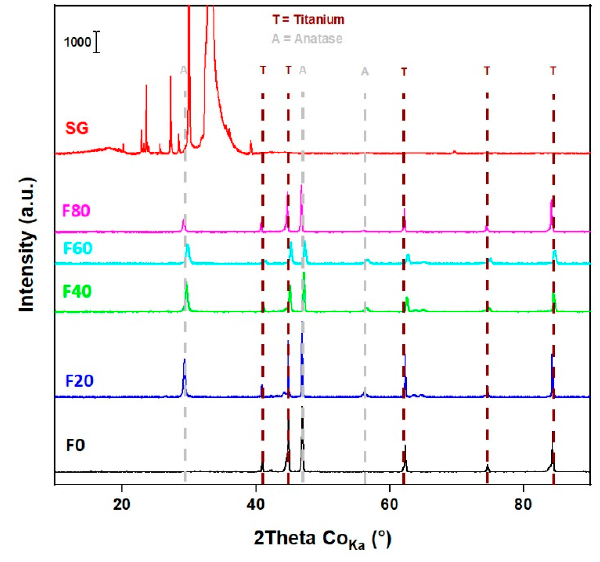
Figure 1. XRD of the TiO 2 nanostructures.